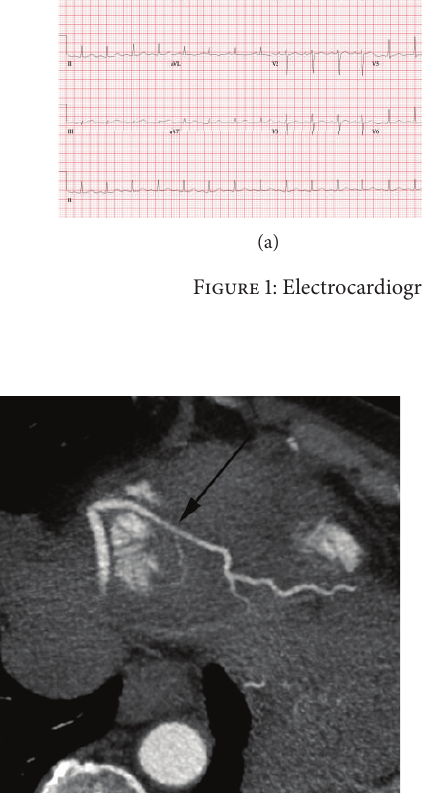
Figure 2: 4.5 mm maximum intensity projection curved multipla- narreformattedcardiacCTimagedemonstratingsmoothnarrowing of proximal/mid portion of early arising PDA with no discernable